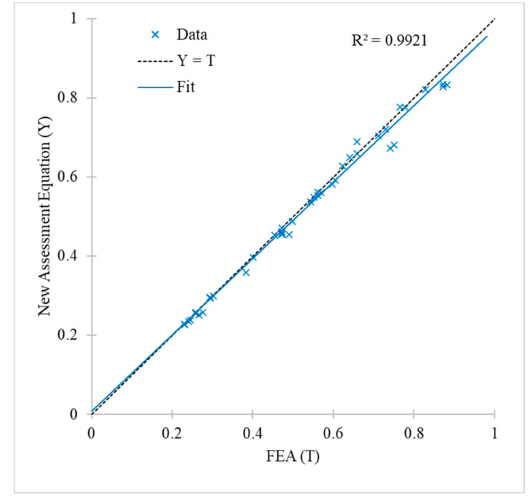
Figure 17. Regression plot of the predicted normalised failure pressures based on the equations and FEA results from unseen